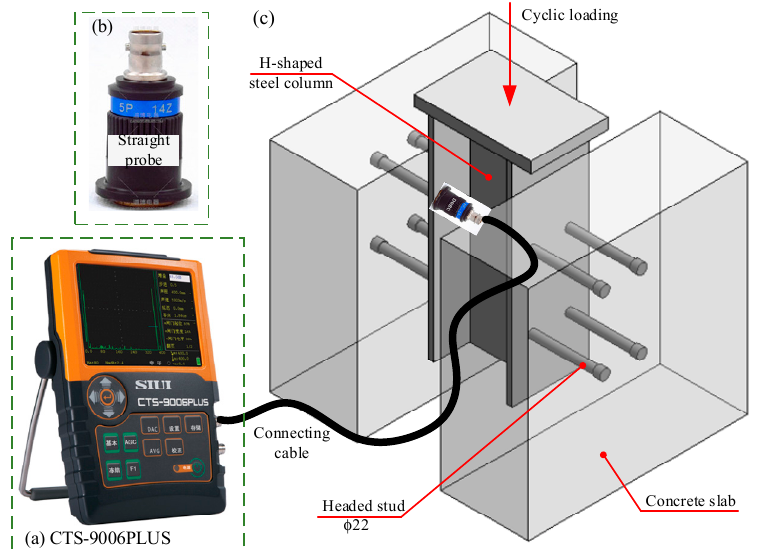
Figure 9. Ultrasonic non-destructive crack testing of headed shear studs: ( a ) digital ultrasonic flaw detector (CTS-9006PLUS); ( b ) straight probe; ( c ) detection scheme. detector (CTS-9006PLUS); ( b ) straight probe; ( c ) detection